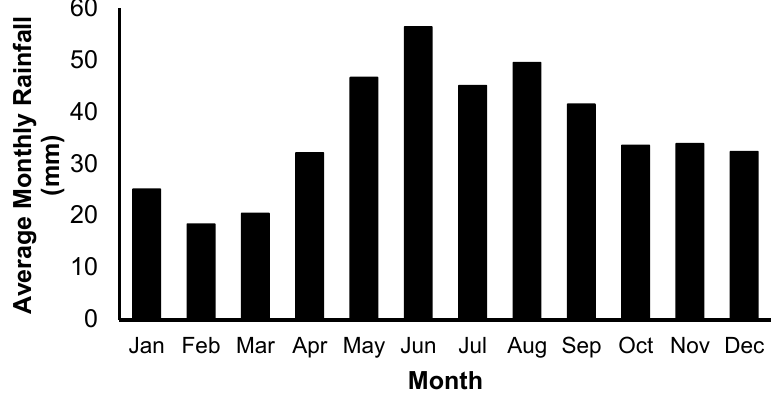
Figure 2. Distribution of monthly average rainfall (2000–2019) in the Willochra Basin [43]